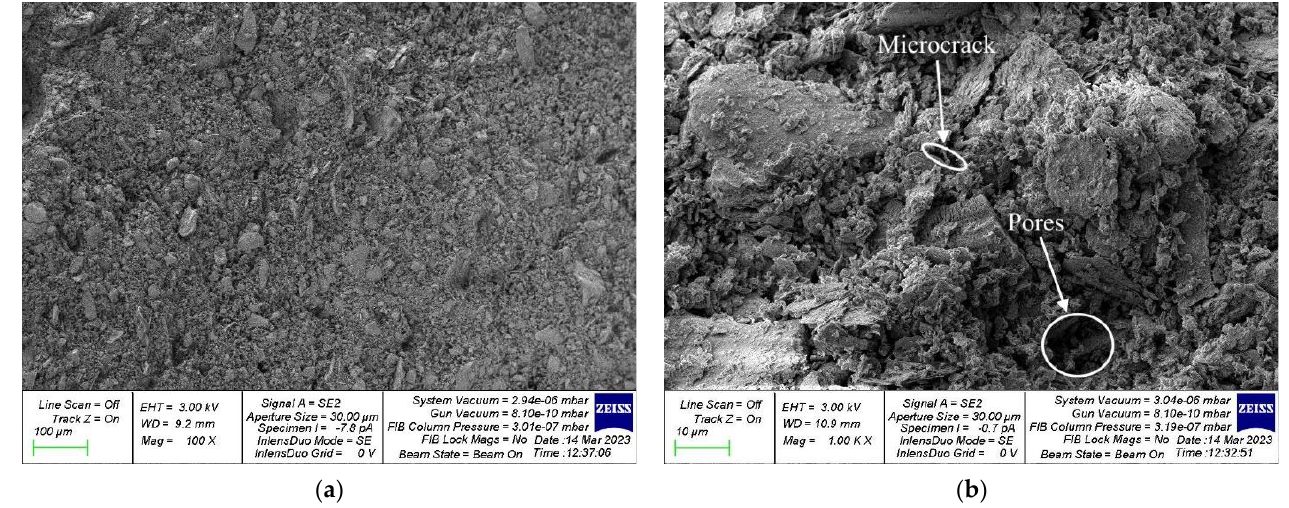
Figure 12. A sample of geopolymer concrete of composition type 4A/6: ( a ) 100×; ( b ) 1000×.